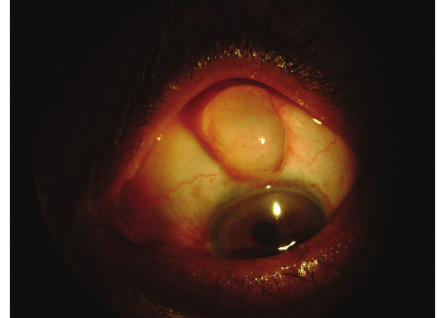
Figure 2: Bleb transillumination as seen in the first case.